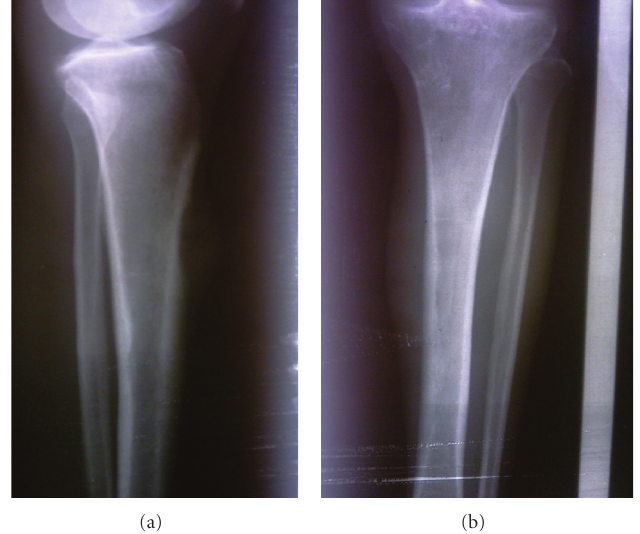
Figure 1: Simple X-ray of lower extremity. Slight thinning of the anterior cortex without cortical destruction.